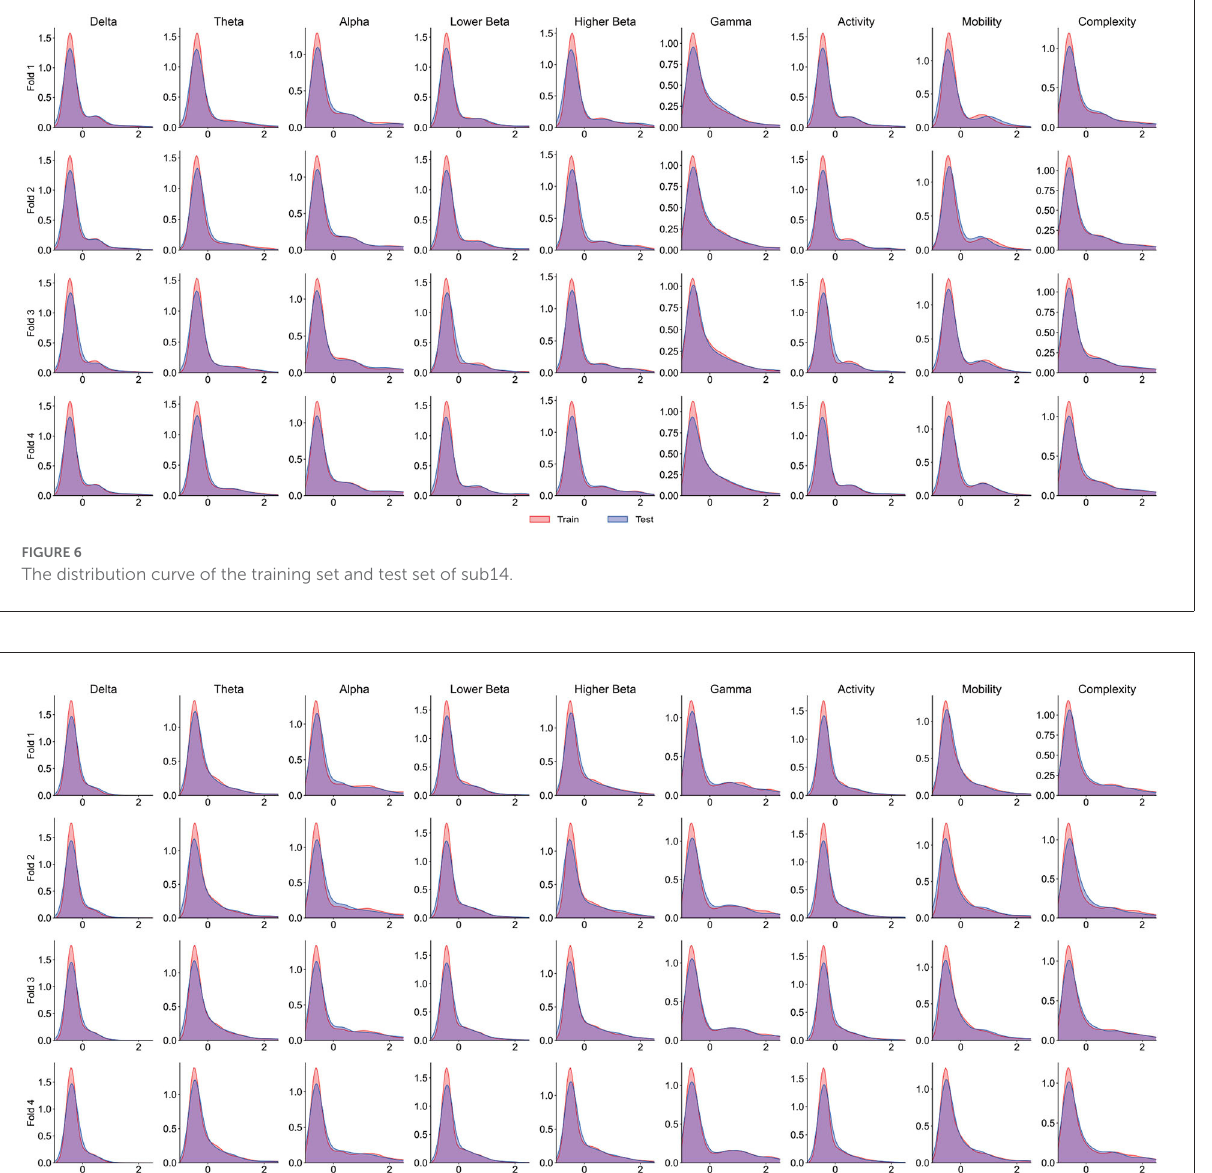
FIGURE7 The distribution curve of the training set and test set of sub20.